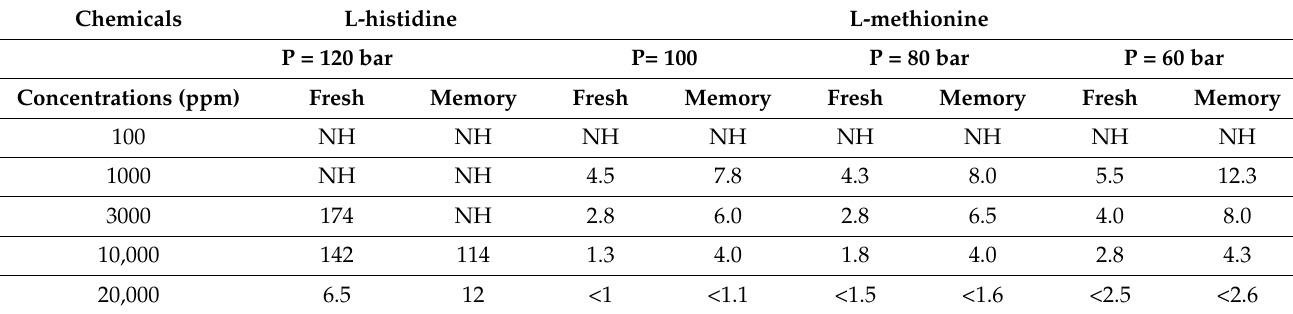
Table A5. Information on induction time (to) (in mins) in the presence of L-methionine and L-histidine for fresh and memory runs at different concentrations. NH indicates that there is no rapid hydrate formation.